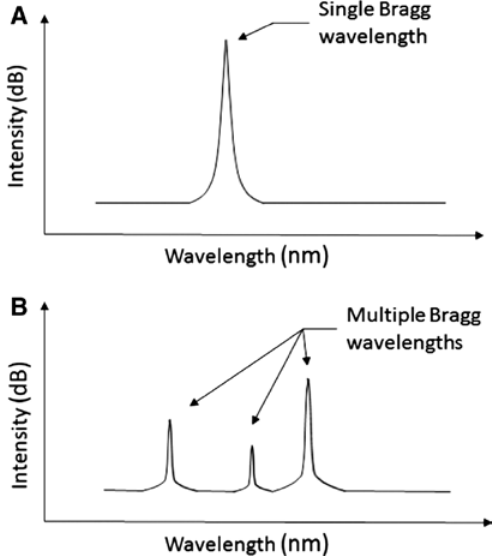
Figure 1: Schematics for reflected FBG spectrum from even strain field (A) and peak splitting resulting from uneven strain field (B).